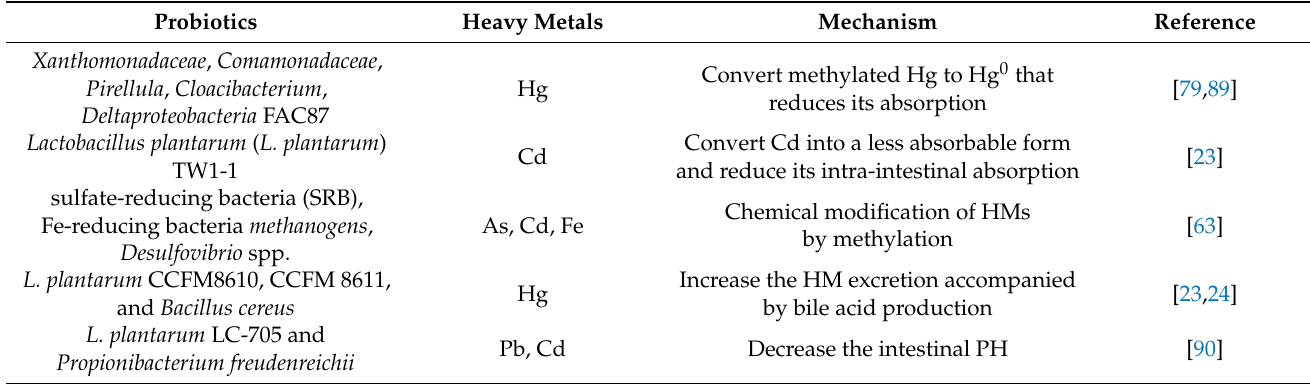
Table 2. Heavy metal detoxification by probiotics and their possible